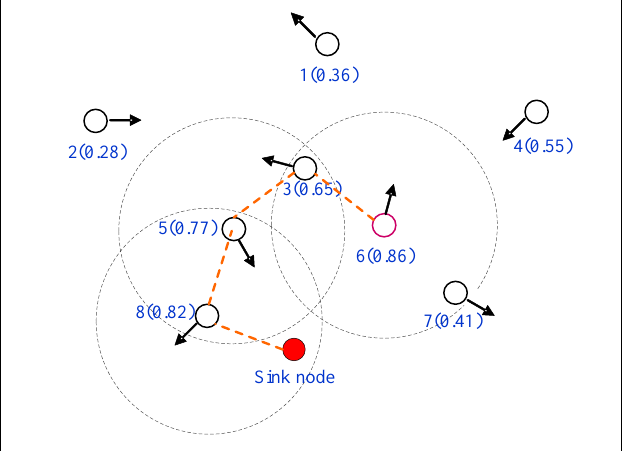
Figure 1. Illustration of next hop